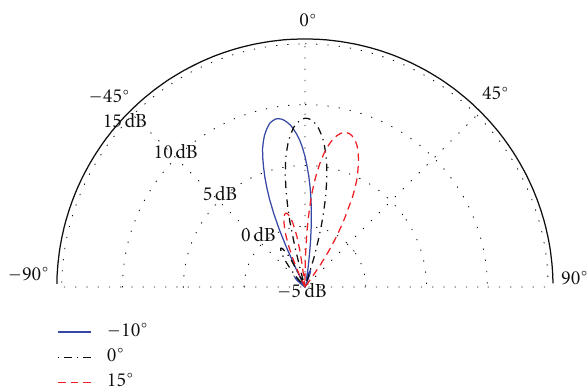
Figure 6: Radiation pattern in the azimuth plane with direction of maximal gain at − 10 ◦ , 0 ◦ , and 15 ◦ .